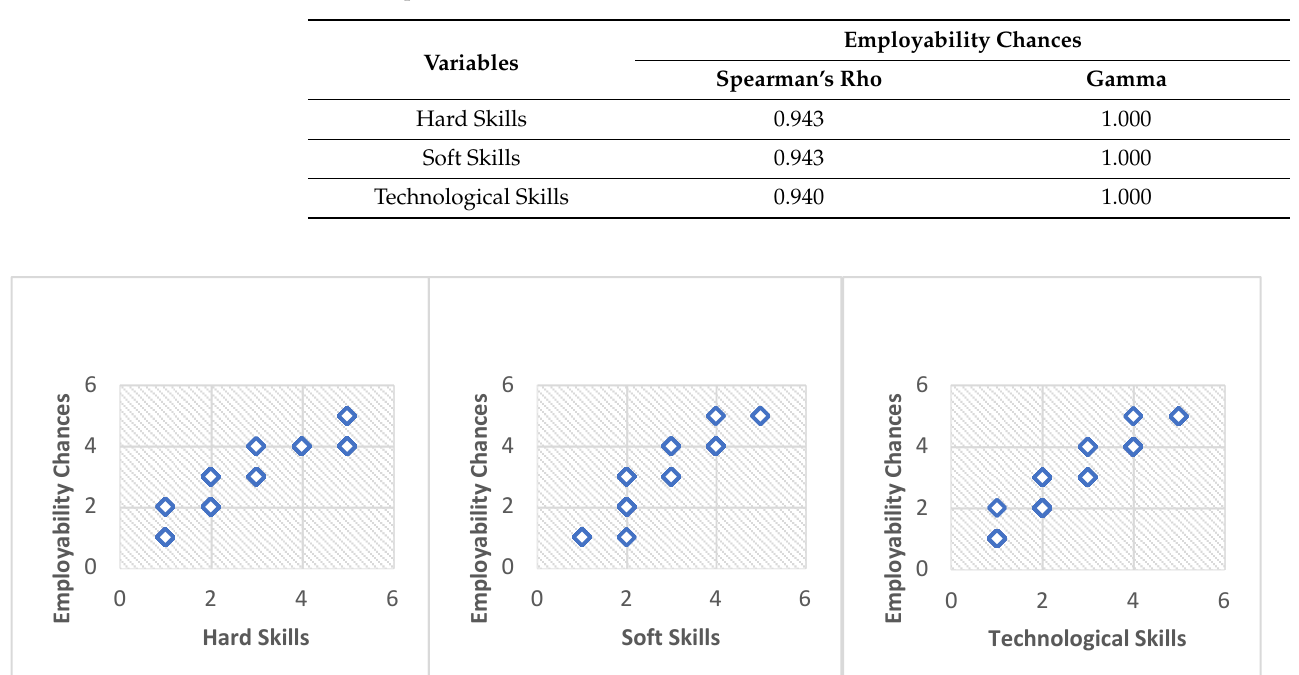
Figure 2. Scatterplot showing relationship between the self-evaluation of the graduates on their ‘hard skills,’ ‘soft skills,’ ‘techno-logical skills,’ and their ‘employability chances’.